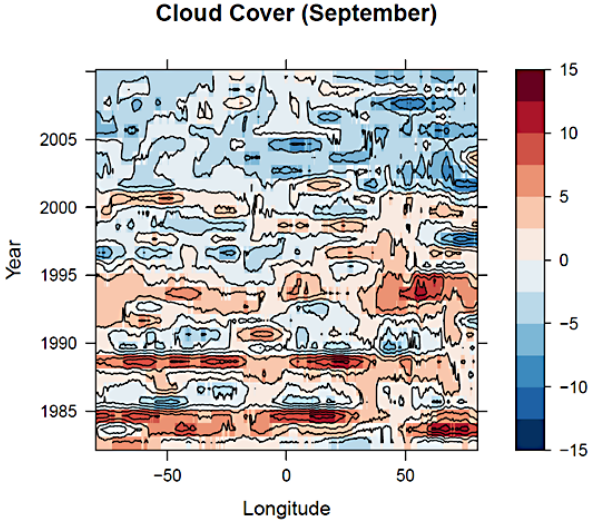
Figure 7. Hovmöller diagram of cloud cover anomalies (in %) for Europe from 1982 till 2009 based on CM SAF